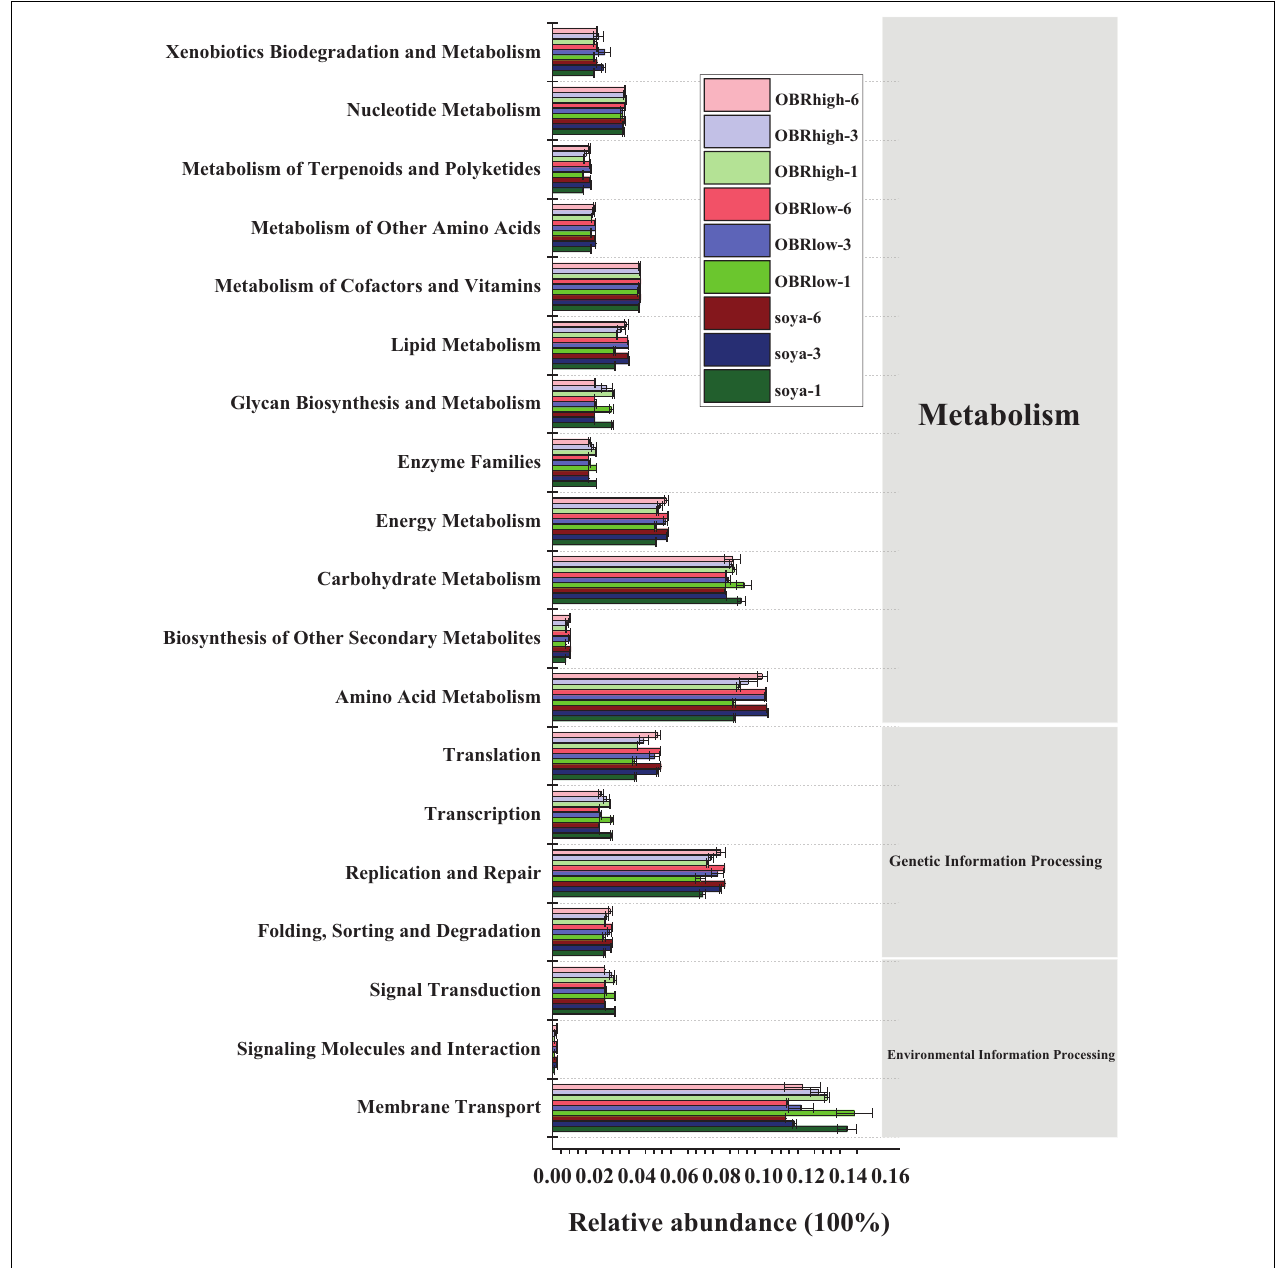
FIGURE 7 | Predicted functions of the gut bacterial community in the KEGG pathway analysis performed using PICRUSt based on the KEGG database (mean n = 3). The soya, OBRlow, and OBRhigh represent treatments containing only soybean meal, a low amount of OBR, and a high amount of OBR, respectively, 1, 3, and 6 represent the first, third, and sixth day,